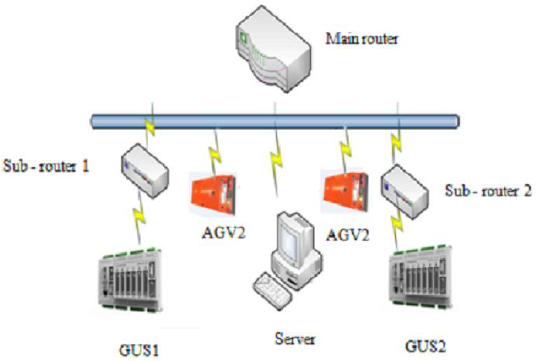
Fig. 2. Communication network diagram of stereoscopic warehouse